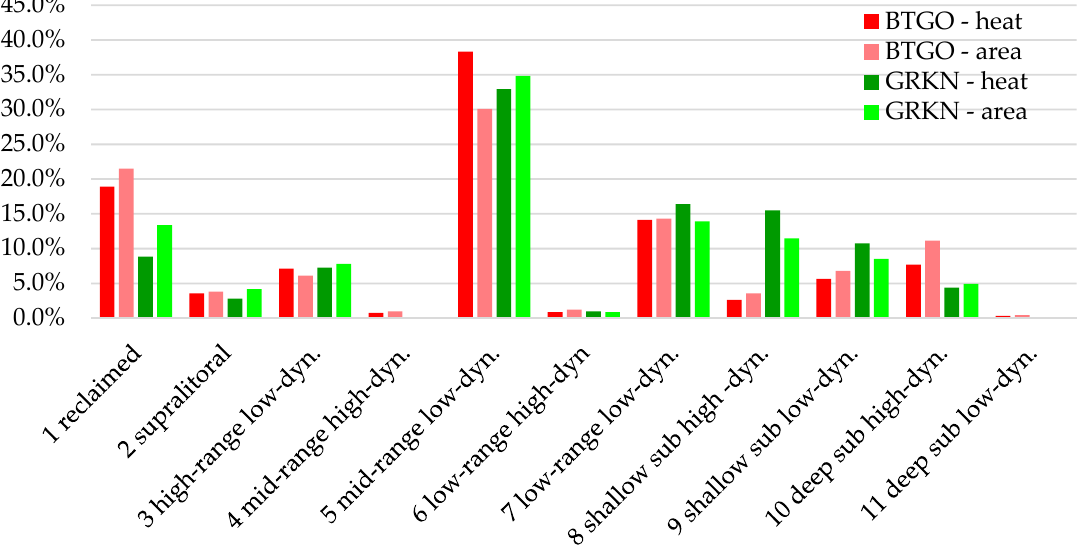
Figure 9. Percentage of “heat” (Kernel density) and area of the 90% home range overlapping with each type of ecotope for Bar-tailed Godwit (BTGO) and Great Knot (GRKN).